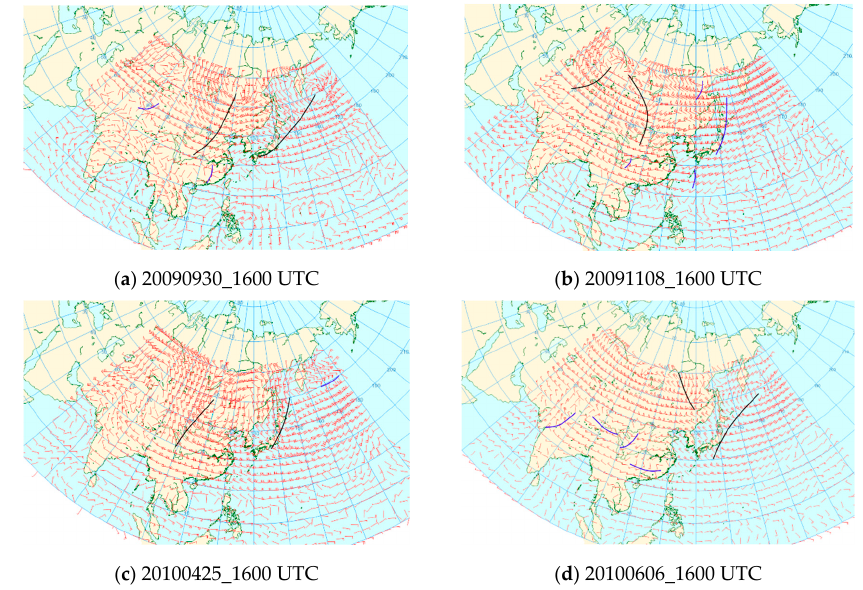
Figure 7. ( a – d ) Objective analysis results of trough line data from 1600 UTC on 30 Sep 2009, 25 Apr 2010, 6 Jun 2010, and 8 Nov 2010. Examples were selected randomly from 70 groups of experimental results. The black solid lines represent longwave trough lines and the blue solid lines are shortwave trough lines.